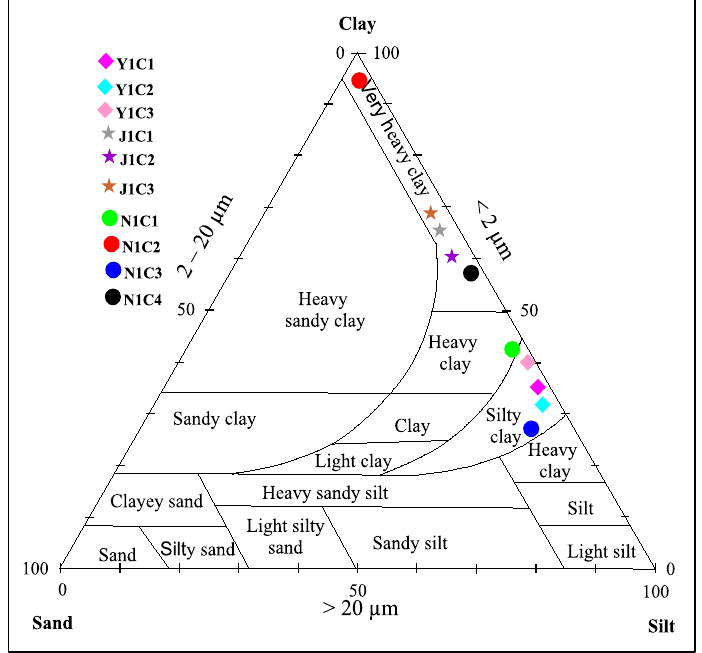
Figure 10. Classification of the clay materials of the eastern part of the Douala sub-basin according to the Belgian triangle of textures [36].